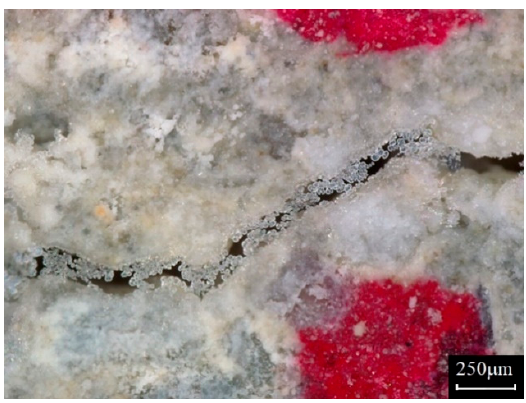
Figure 1. Irregular healing products on the crack surface.